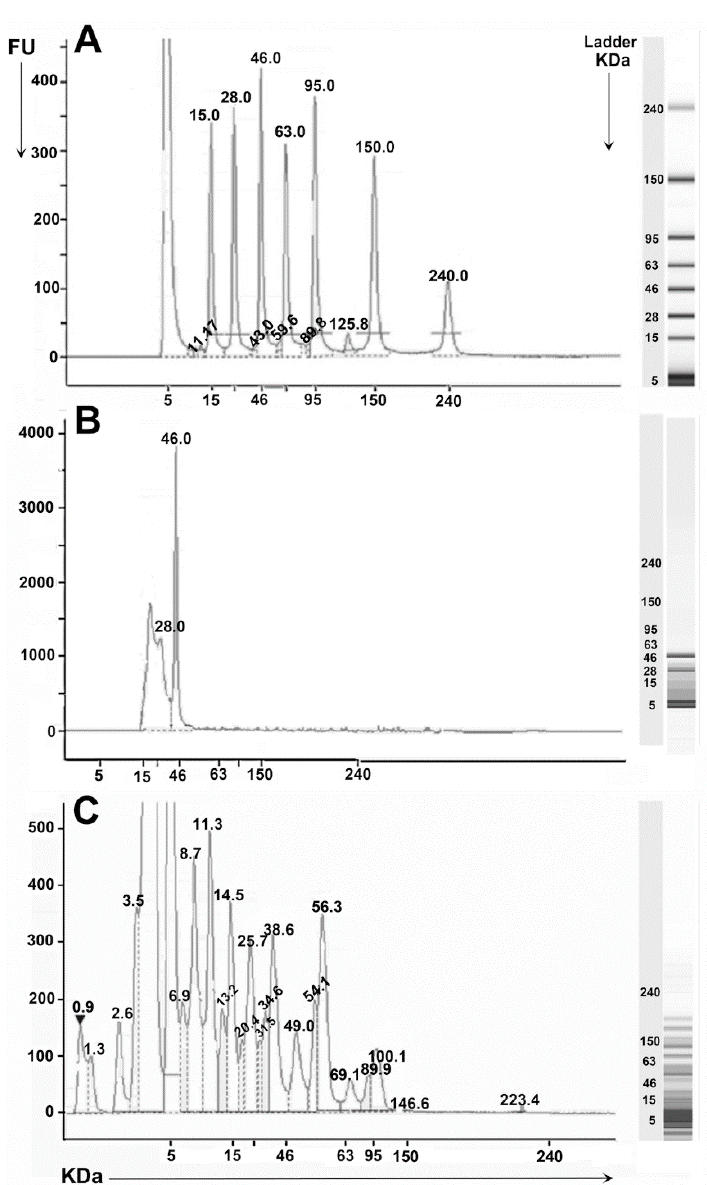
Figure 1. Lab-on-a-chip capillary electrophoresis with elution profiles. Migration pattern for ( A ) proteins, ( B ) non-treated (control) skim milk proteins and ( C ) fermented skim milk protein hydrolysis from the combination of L. helveticus 881315 and Flavourzyme ® following incubation for 12 h at 37 ◦ C. Molecular weights (ladder; KDa) are